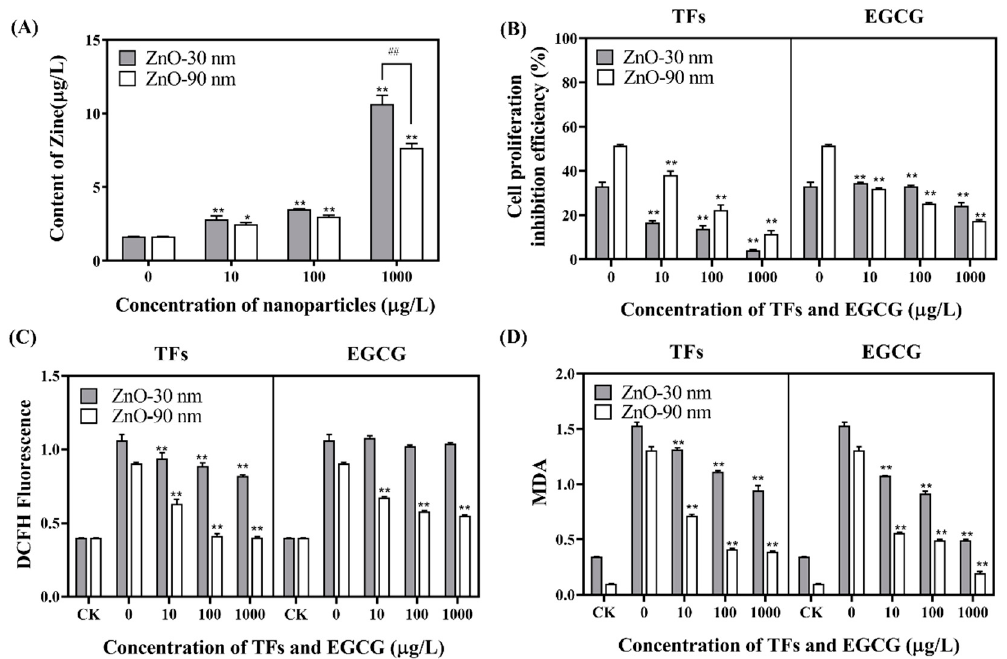
Figure 1. The detection of the zinc content in RTE cells induced with 30 nm ZnO-NPs and 90 nm ZnO-NPs for 12 h by ICP ( A ). Effects of 100 μ g/L of ZnO-NPs with different sizes (30 nm and 90 nm) and the treatment with different concentrations of TFs and EGCG (10, 100, and 1000 μ g/L) on the cell proliferation inhibition efficiency ( B ), and the generation of ROS ( C ), MDA ( D ) in RTE cells for 12 h. CK was blank group (the group with neither sample nor NPs treatment). The data was represented as the means ± standard deviation. The asterisks denoted responses that were significantly different from the 0 μ g/L group (* p < 0.05, ** p < 0.01). Hash signs indicate significant differences between two selected groups (# p < 0.05, ## p < 0.01).